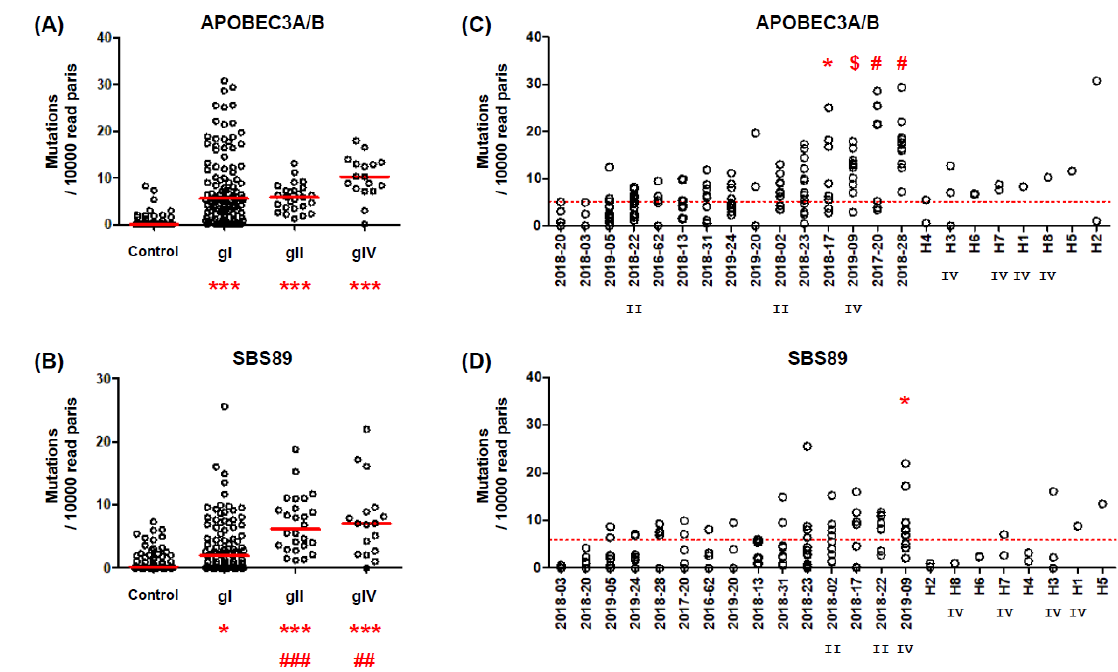
Figure 2. APOBEC3A/B and SBS89 mutation rates in relation to virus genotype and patient. ( A ) APOBEC3A/B and ( B ) SBS89 mutation rate by virus genotype. Each symbol represents the mean of 50 SBS fitting iterations of data from a single sample, and red lines indicate the median for each group. Sample types were compared by the Kruskal–Wallis test, and Dunn’s multiple comparison post-hoc test. Symbols indicate: * p < 0.05, *** p < 0.001, compared to plasmid controls. ## p < 0.01, ### p < 0.001 compared to gI virus. All other differences between groups were not sig- nificant. ( C ) APOBEC3A/B and ( D ) SBS89 mutation rate by patient, arranged in order of lowest to highest mean among Nantes and Hanoi patients. Each symbol represents the mean of 50 SBS fitting iterations of data from a single sample. APOBEC3A/B mutation rates among Nantes patients were compared by one-way ANOVA, and Dunnett’s post-hoc test, with patient 2018-20 as the comparator. Symbols indicate: * p < 0.05, $ p < 0.01, # p < 0.001. No other significant differences were observed. Dotted red lines show the 95th percentiles of APOBEC3A/B and SBS89 mutation rates observed in plasmid controls (n = 60). BKPyV genotypes II and IV are indicated beneath the patient